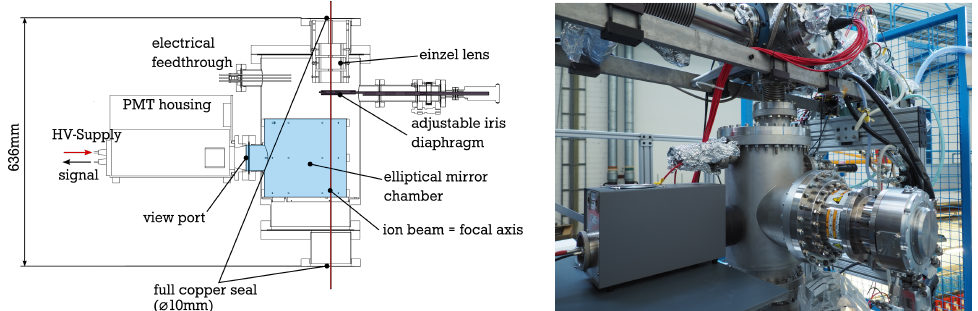
Figure 2. Schematic drawing of the optical detection region ( left ) and photo of the assembled vacuum system ( right